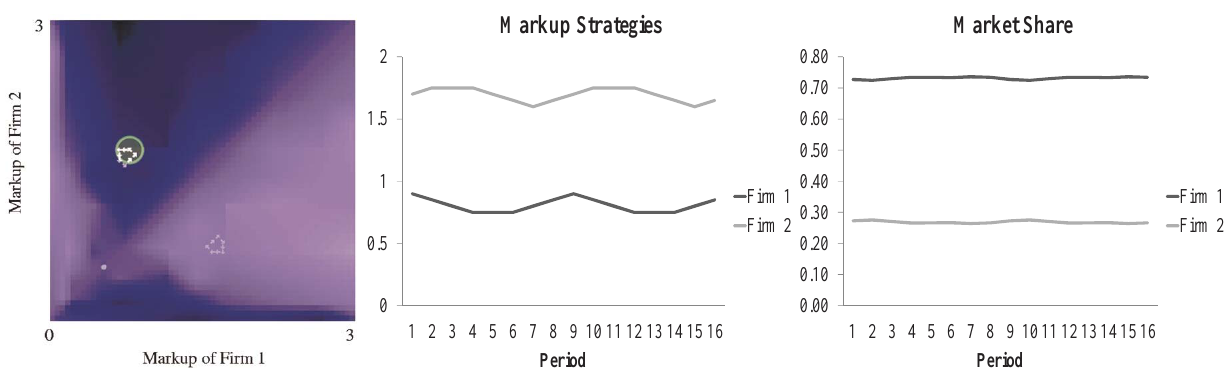
Figure 14. Long-run dynamics of markup rates: simultaneous